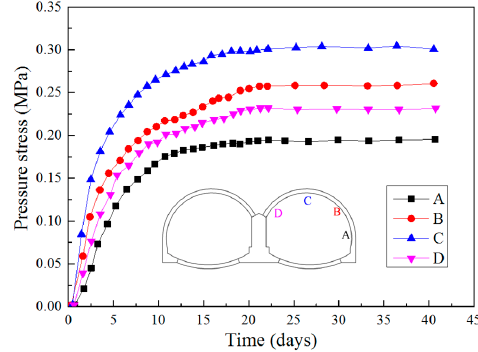
Figure 13. Time history plots of the contact pressures between surrounding rocks and primary linings in the K89+729 section.